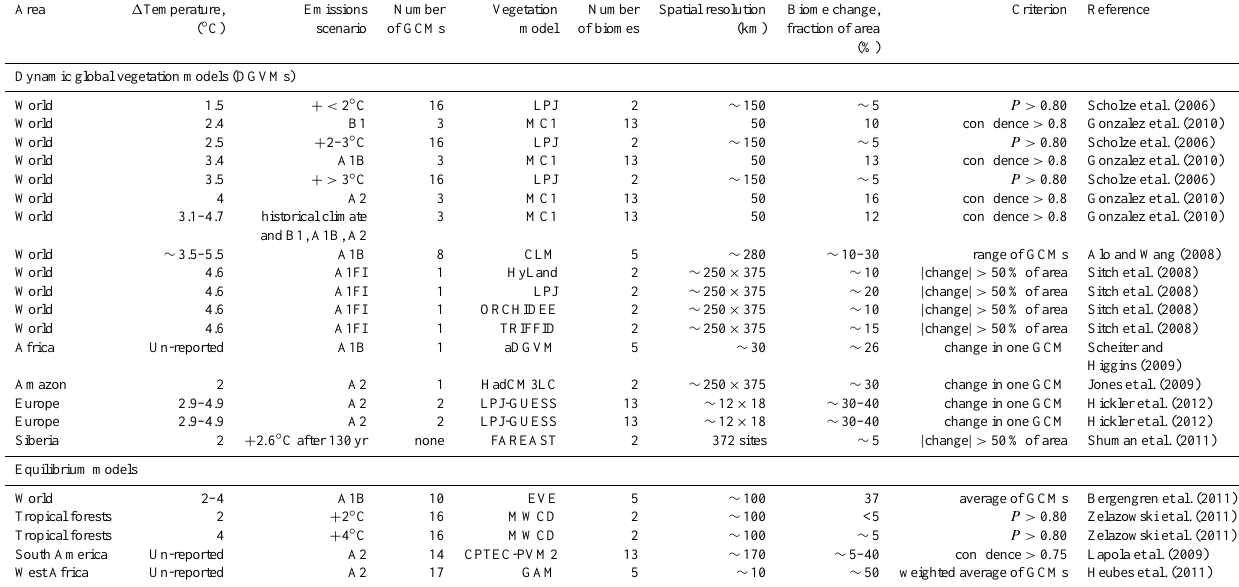
Table 1. Studies of projected biome changes. B1, A1B, A2 and A1FI refer to emissions scenarios from the IPCC Special Report on Emissions Scenarios (SRES; Naki´cenovi´c et al., 2000). Area Dynamic global vegetation models (DGVMs)